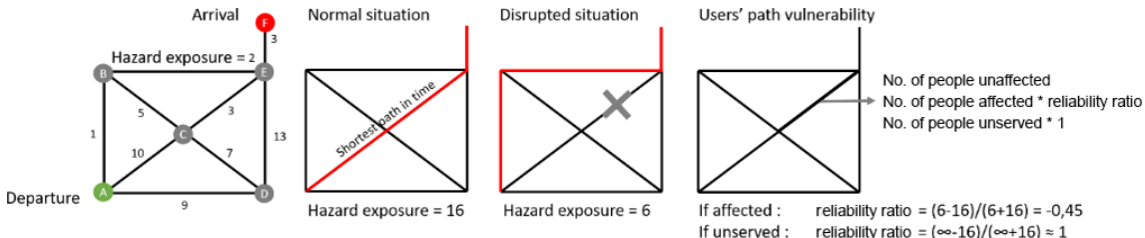
Figure 5. Accessibility assessment before and after a disruption using Dijkstra’s shortest-path algorithm. People affected and unserved are weighted by the reliability ratio, which assesses how users’ path exposure changes when taking the alternative shortest path in time to access the